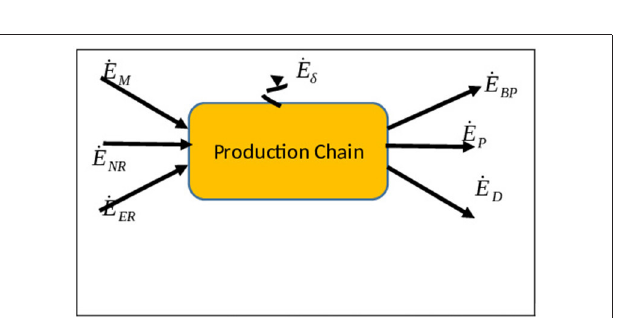
FIGURE 9 | For the calculation of the thermo-ecological exergy cost tec. ˙ E M , exergy rate of materials; ˙ E NR , exergy rate of non-renewables; ˙ E R , exergy rate of renewable energy carriers; ˙ E D , exergy rate of effluents; ˙ E P , exergy rate of main product; ˙ E BP , exergy rate of by-products; ˙ E δ , exergy destruction rate.